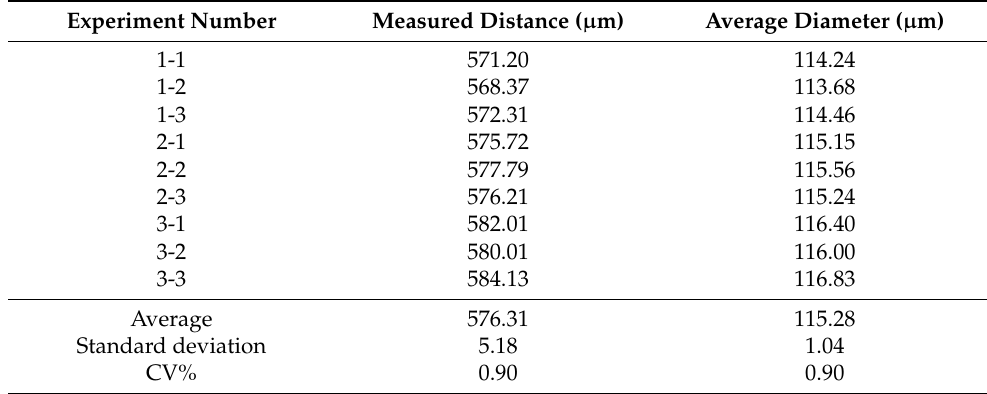
Table 4. Results of the uniformity of the generation droplets ( N =